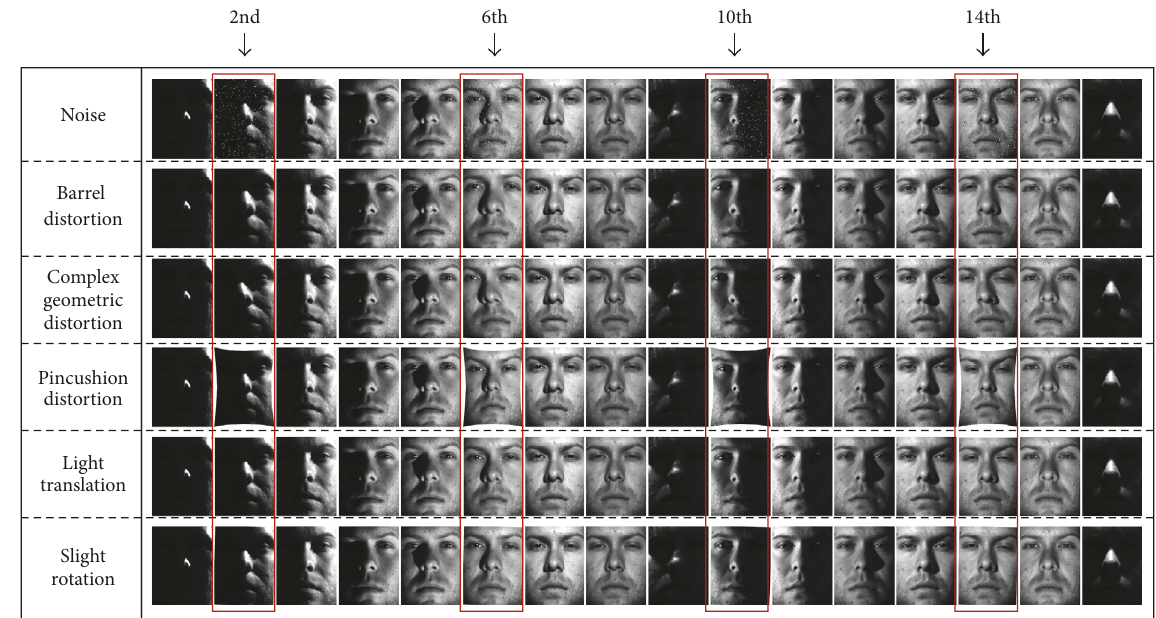
Figure 7: The details for the noise, geometric distortion, slight translation, and slight rotation Extended Yale B face databases.